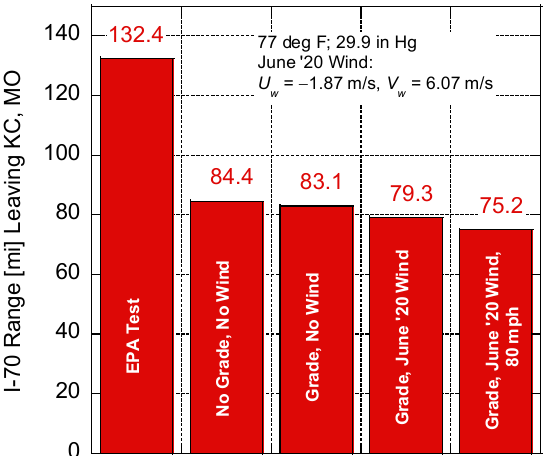
Figure 11. Illustration of road grade, wind, and vehicle speed influences on range of Nissan Leaf under EPA-tested ambient conditions.